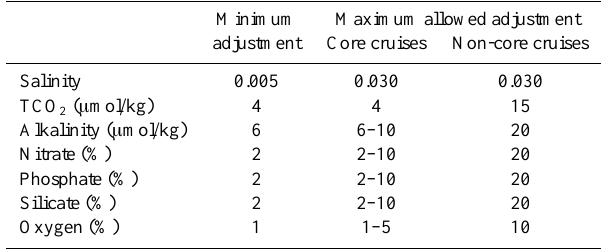
Table 3. Minimum adjustment applied to the data product and the maximum allowed adjustment in the Weighted Damped Least Square (WDLSQ) inversions for core cruises identified in Table 2 and non-core